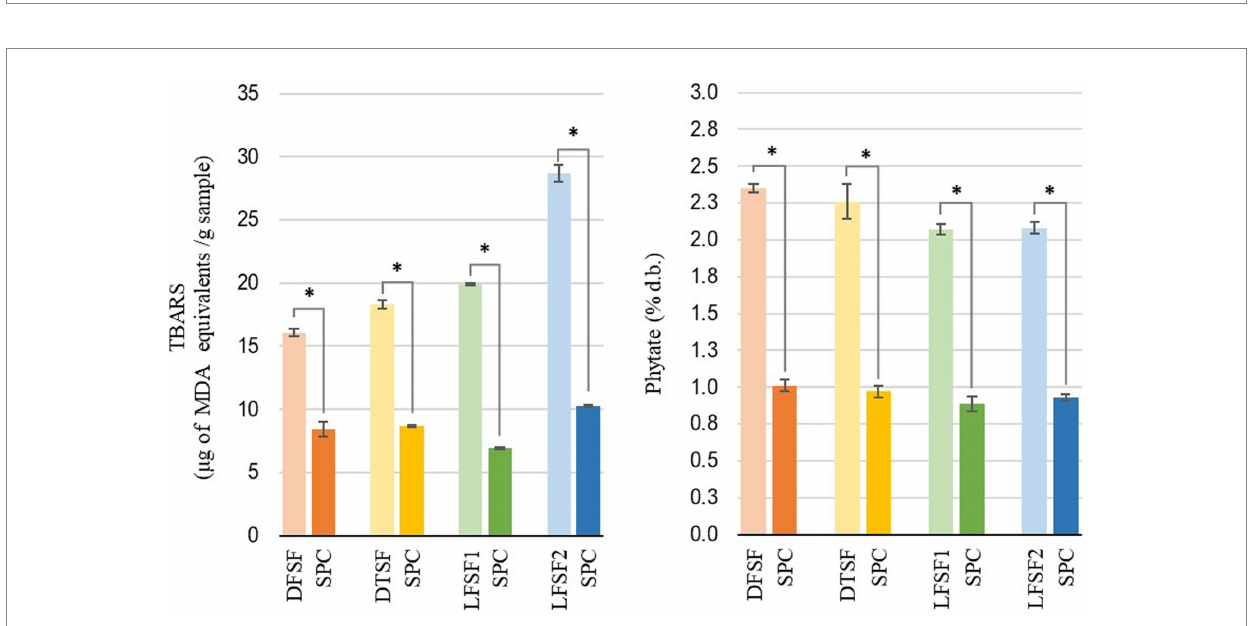
FIGURE 3 Thiobarbituric acid reactive substances (TBARS) measured as malondialdehyde equivalents (left) and total phytate content (right) of raw materials and their soy protein concentrates (SPCs) (30 min, 22 ° C) produced at the bench scale. Symbol (*) represents statistical difference between the raw material and its SPC (Fisher’s LSD test; p <